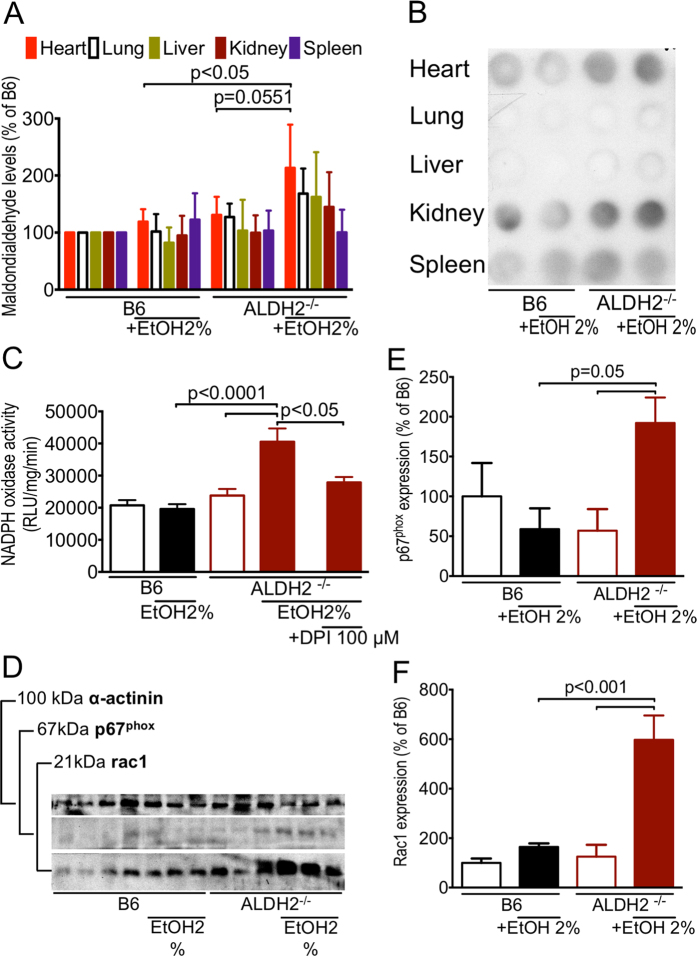
Increased myocardial ROS in ALDH-2−/− mice fed a 2% alcoholic diet.(A) Malondialdehyde levels in internal organs as determined by dot blot analysis of tissue homogenates. Data are expressed as mean ± SEM from n = 4 per group. (B) Representative original dot blot; (C) NOX activity in myocardial membrane fractions determined by lucigenin-derived chemiluminescence. Data are presented as mean ± SEM from 18–20 measurements of n = 5 animals per group. (D) Representative original Western blot. (D) p67phox protein expression and (F) Rac1 protein expression determined by Western blot. Data presented as mean ± SEM from n = 3–4 animals per group.